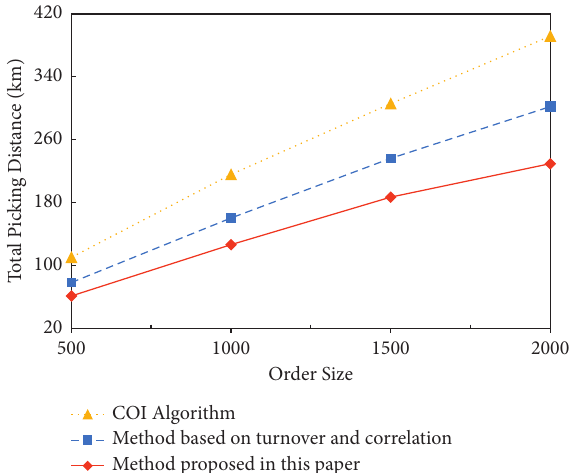
Figure 4: Total piking distance of different methods.